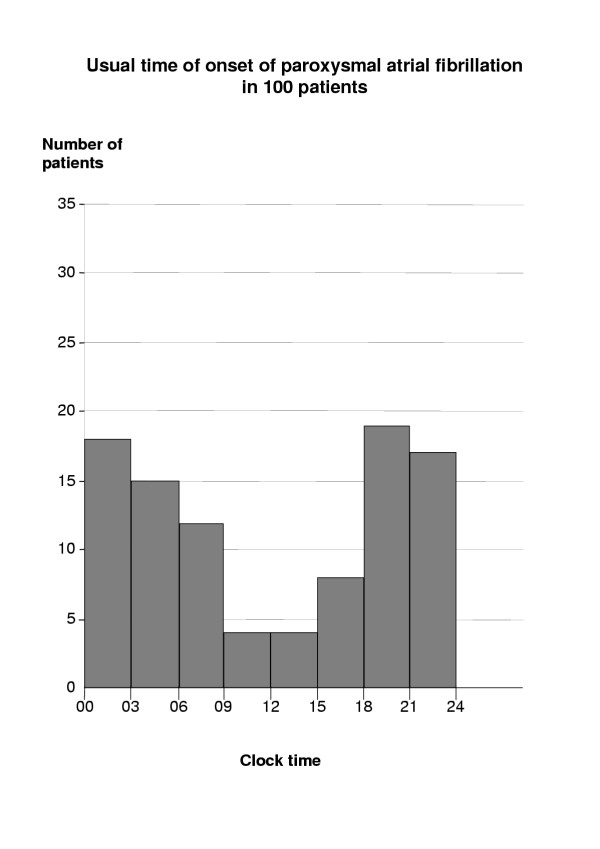
Time at which palpitations started. Seventy-two patients thought that arrhythmia always started at the same time of day, typically in the evening or at night. Some, however, gave more than one time-interval.